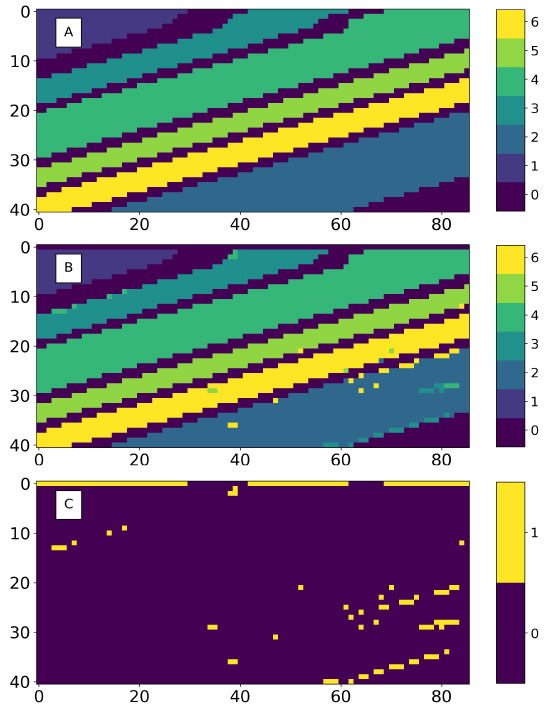
Figure 7: A: Salinas test data ground truth, B: Self-learning MLM’s top-down, row by row (RBR) classification map, C: Row- by-row classification error map.